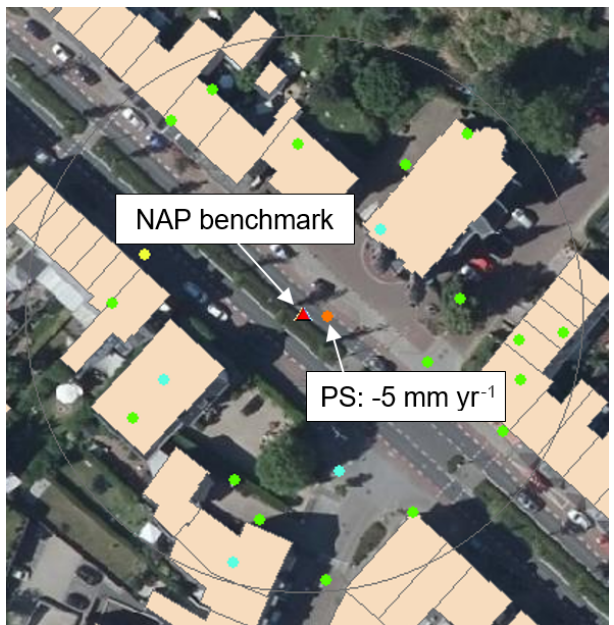
Figure 2. Example where the estimated rate of the benchmark is affected by a PS on the ground close to the documented position of the benchmark, whereas the actual location is at the front of the